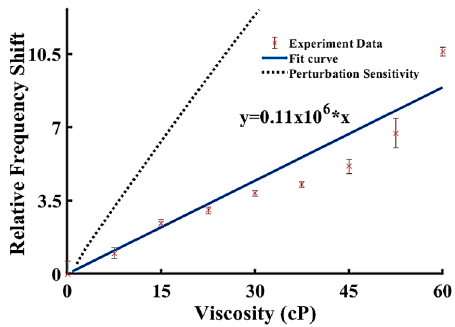
Figure 7. Sensitivity (frequency shift) comparison between the experiment results and model predictions of varying viscosity glycerol solution.